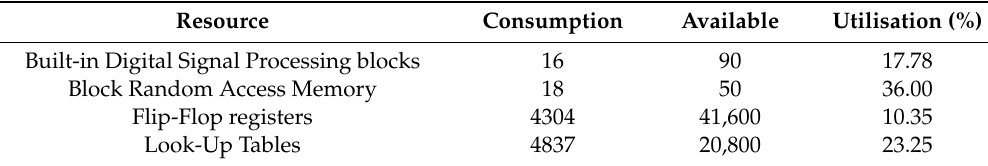
Table 3. Results of utilisation of the hardware resources of XC7A35T FPGA device.